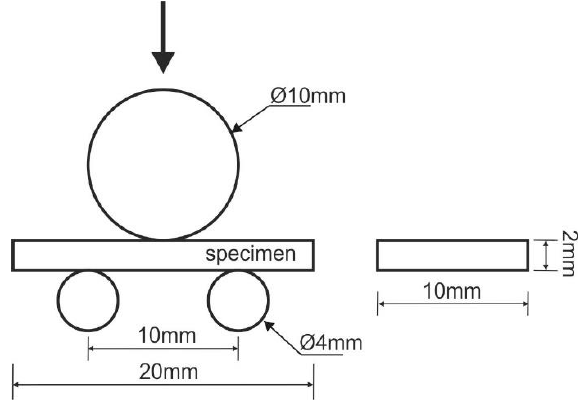
Figure 3. Schematic configurations of the short beam shear test specimen.